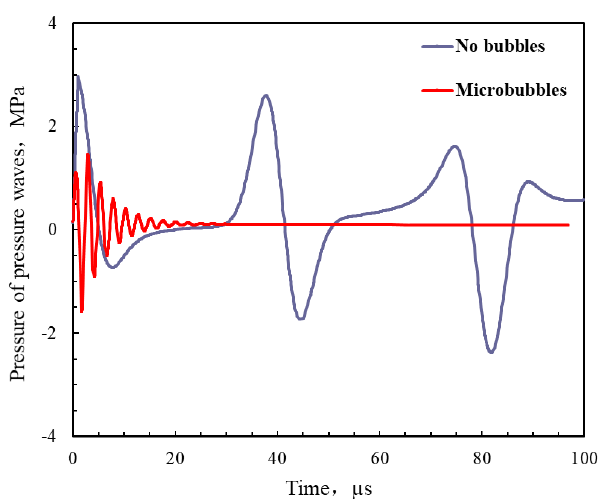
Figure 12. Comparison of microsecond-scale pressure waves under different working conditions.